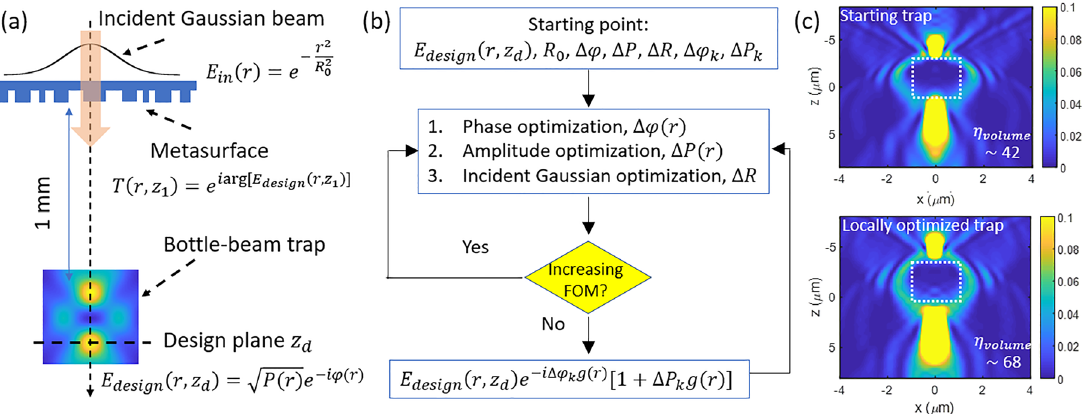
Figure 4: (a) Schematic of the gradient-ascent optimization setup. First, the target field at the plane z = z d near the trap center is back- propagatedtothemetasurfaceat z = z 1 ,wherethephaseof E design ( r , z 1 )isusedasthetransmissionphaseofthemetasurface.Themetasurface is illuminated with a collimated Gaussian beam and the transmitted fi eld produces the bottle-beam trap. (b) Flowchart of the point-by-point gradient-ascent optimization. Each iteration goes through three steps: optimization of the phase and amplitude of E design ( r , z d ), as well as the incident Gaussian beam width. If η stops increasing, the program attempts to jump out of the local optimum by adding random variations to both the amplitude and phase of E design ( r , z d ). (c) Pro fi les of the input [top, the trap in Figure 3c] and locally optimized (bottom) volume bottle- beam traps, where the η of the bottle-beam trap is increased by more than